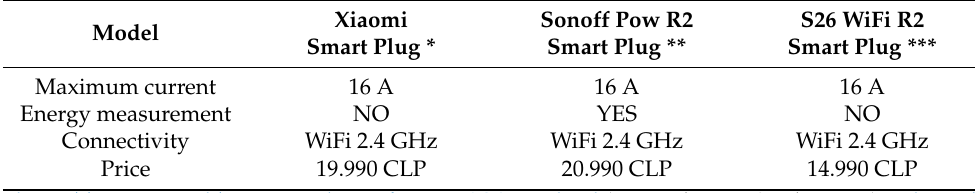
Table A1. Characteristics of smart plug devices.